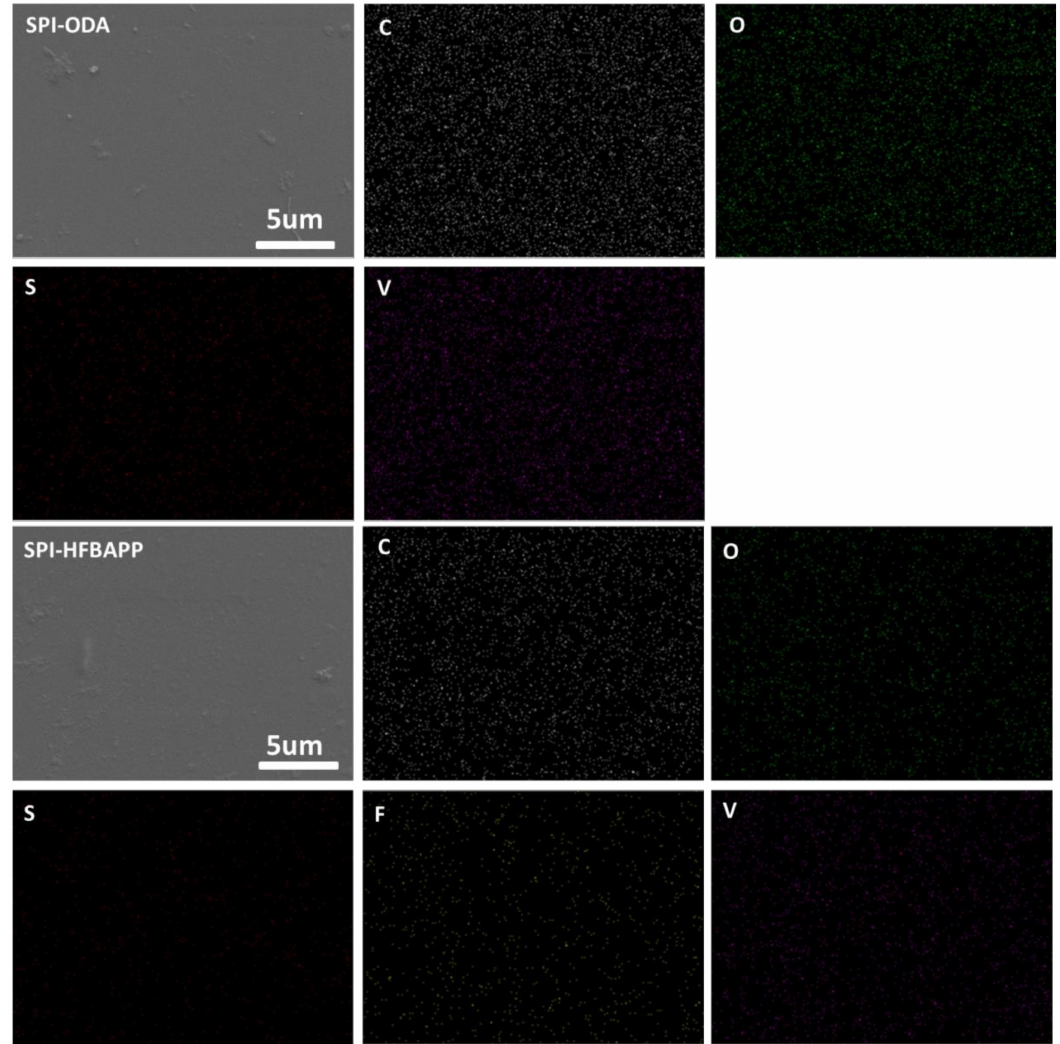
Figure 9. EDX images of SPI membranes after cell cycling. C : carbon; O : oxygen; S : sulfur; V : vanadium; F :